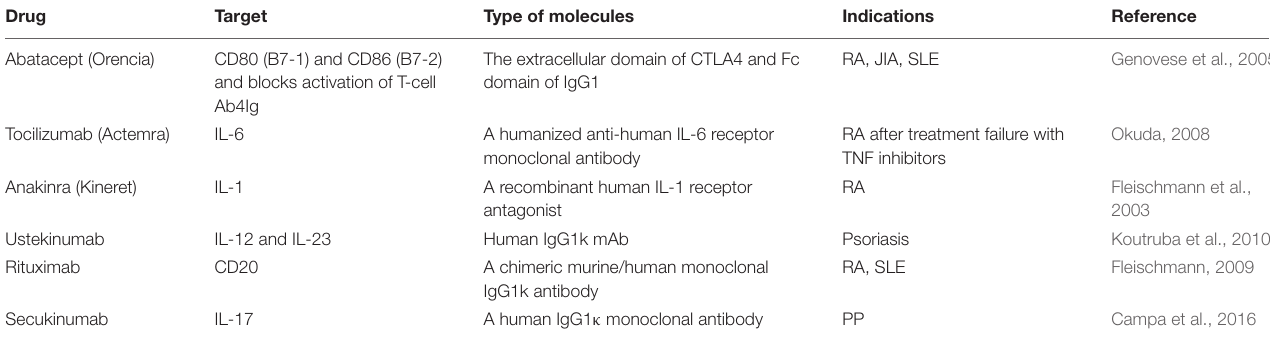
TABLE 2 | Alternative biologic in autoimmune inflammatory diseases.